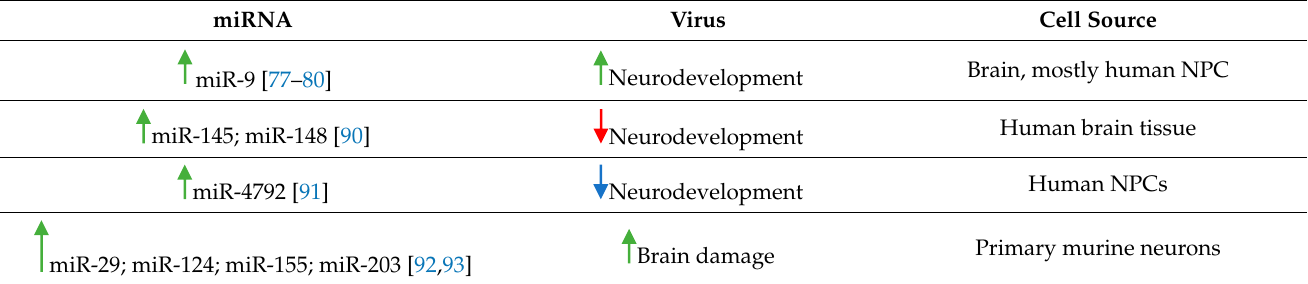
Table 1. miRNAs and neurodevelopment.